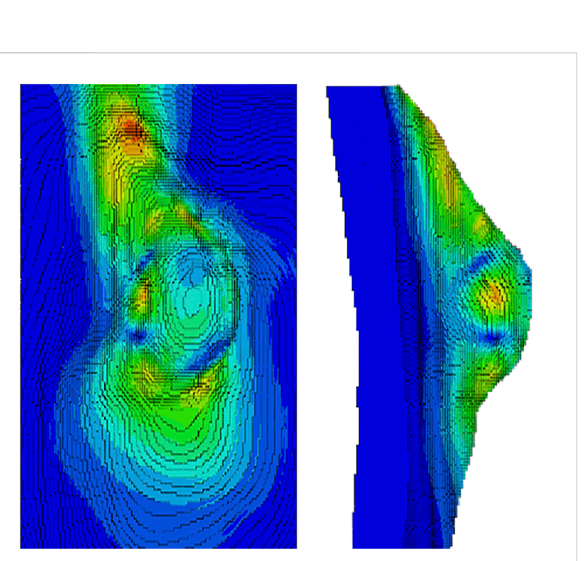
FIGURE 11 Normal breast tissue simulation - the numerical result of the